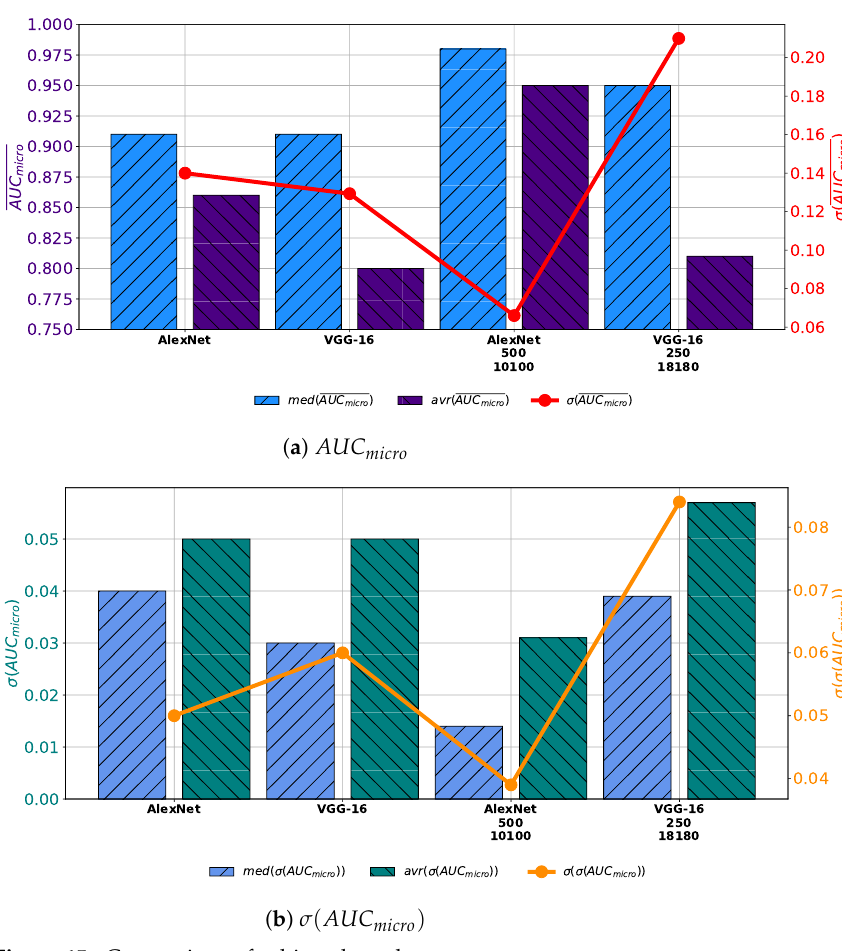
Figure 15. Comparison of achieved